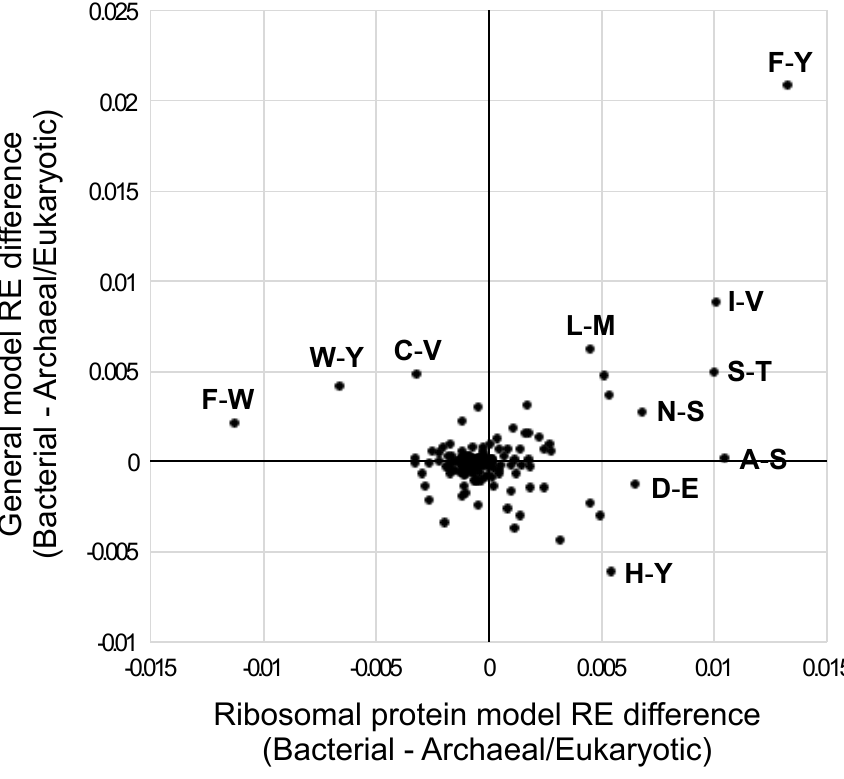
Figure 4. Comparison of RE difference values for bacteria versus archaea/eukaryotes for the riboso- mal protein and general models. RE differences were generated by subtracting the average values for archaea + eukaryotes from those for bacteria. Archaea and eukaryotes were combined based on the near perfect bipartition (for generalized models) or perfect bipartition (for ribosomal protein models) that separated those taxa in our trees of models (Figure 1a,b). Positive values on each axis correspond to REs that were higher in the models trained on bacteria than in those trained using MSAs from archaea and eukaryotes; negative values were higher in the models trained on archaea + eukaryotes than in those based on bacterial MSAs. The REs for all models (along with these RE differences in this graph) are available in Supplementary File